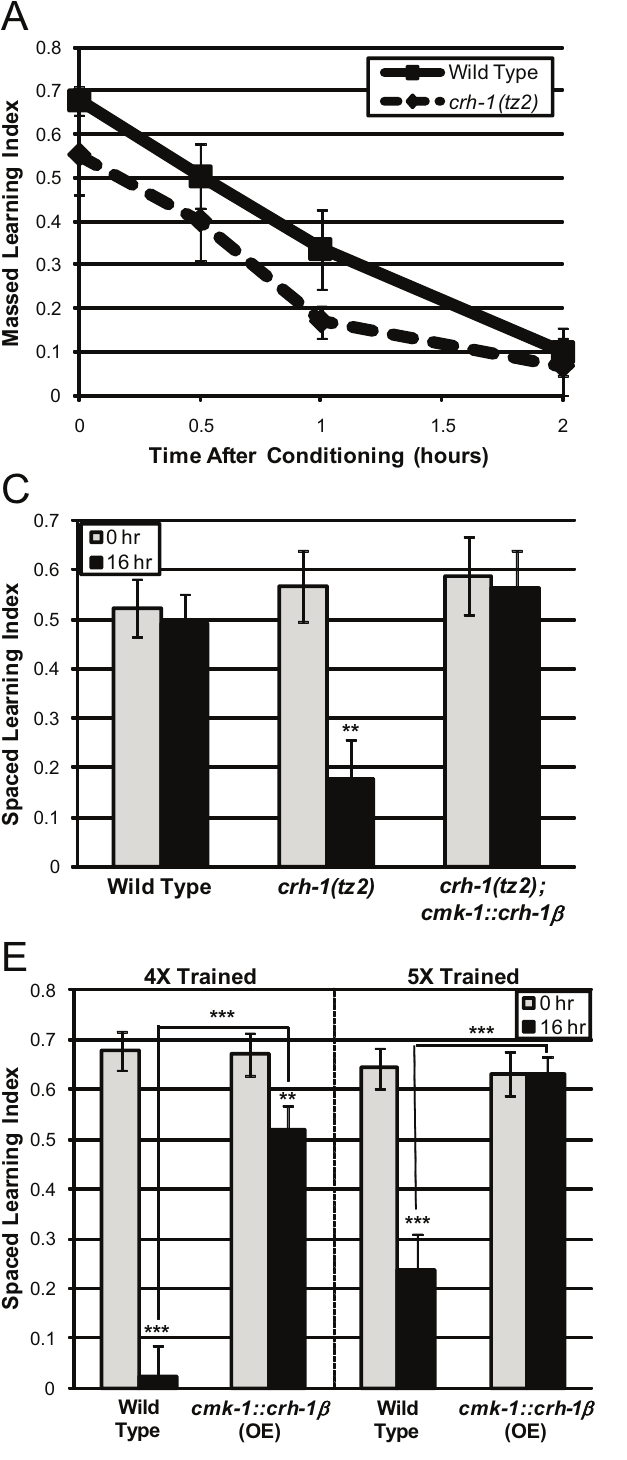
Figure 3. CREB ( crh-1 ) is required for LTAM but not for learning or short-term memory. (A) Massed learning (0 h) and STAM (slope) is similar between wild-type and crh-1(tz2) mutant worms. (B) CREB ( crh-1(tz2) and crh-1(n3315) ) mutants learn after spaced training but are defective for long-term memory. (C) LTAM defect of crh-1(tz2) mutants is rescued by neuronal expression of CREB ( cmk-1::crh-1 b ). (D) Overexpression of CREB in neurons ( cmk-1::crh-1 b ) enhances LTAM performance after 7 6 training. (E) Animals overexpressing CREB form 16 h LTAM faster than wild type. (A–B, D–E): n =6 trials; (C): n =4 trials; 6 SEM; ** p , 0.01, *** p , 0.001.